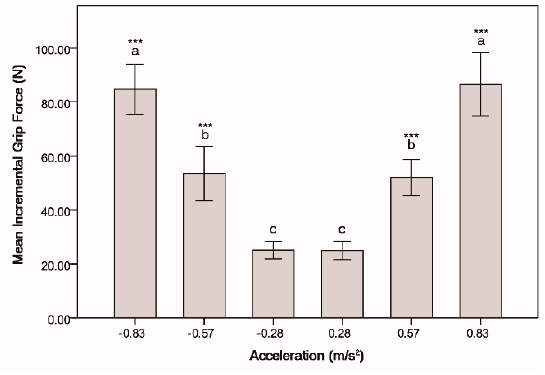
Figure 8. Incremental grip force at each acceleration or deceleration, *** p < 0.0001.